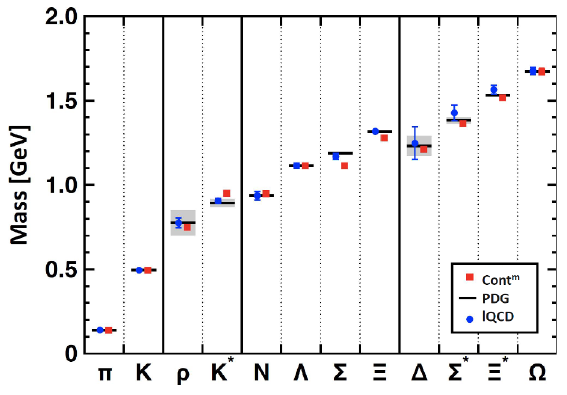
Figure 3. Masses of pseudoscalar and vector mesons, and ground-state positive-parity octet and decuplet baryons calcu- lated using continuum (Cont m – squares, red) [33] and lattice [34] methods in QCD compared with experiment (PDG – black bars, with decay-widths of unstable states shaded in grey) [35]. The continuum study did not include isospin symmetry breaking e ff ects, which are evidently small, as highlighted by the empiri- cally determined Σ - Λ mass di ff